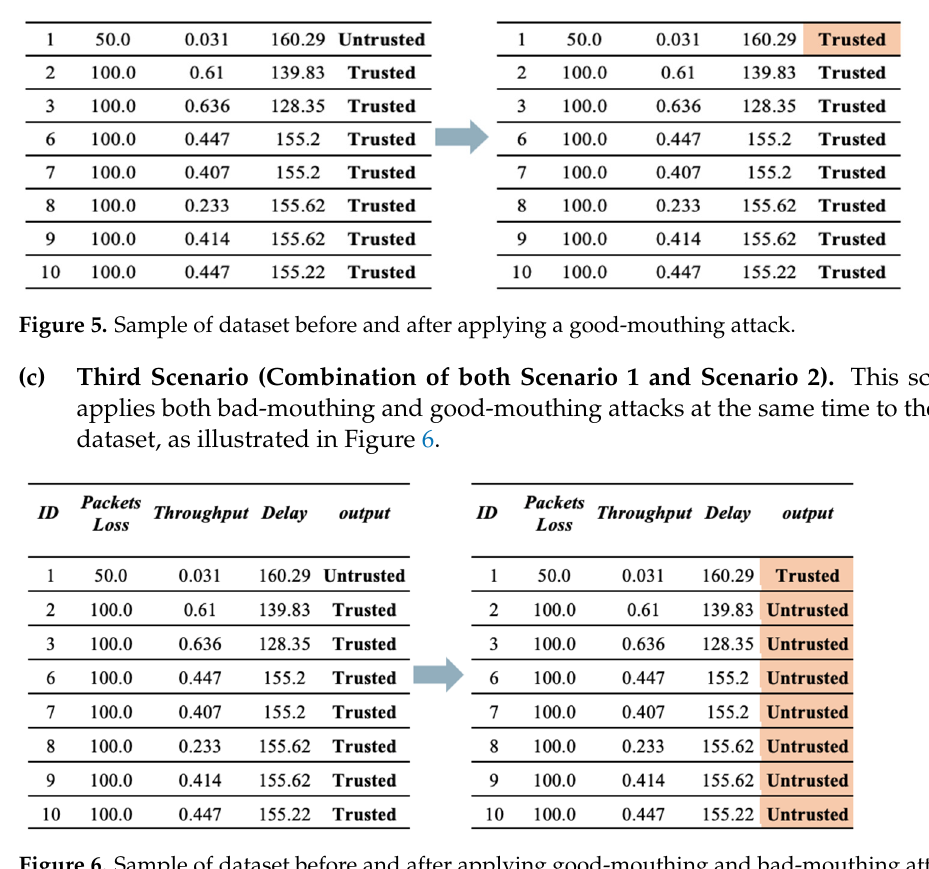
Table 5. Model setup.